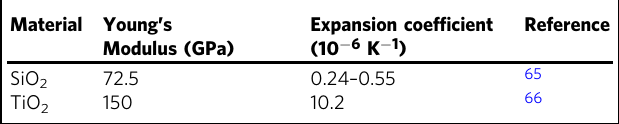
Table 2 Mechanical and thermal paramiters of the SiO 2 and TiO 2